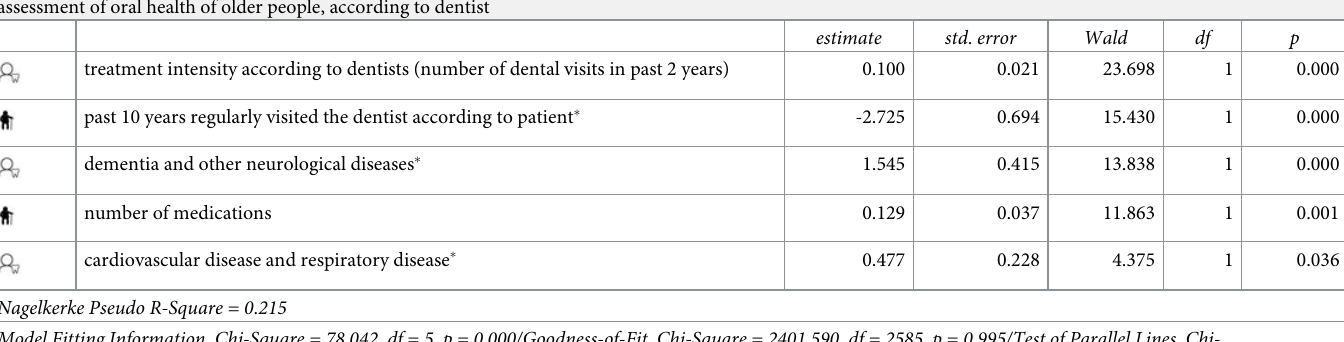
Table 6. Multivariate correlation between characteristics of older people who visit the dental practice and the assessment of their oral health, according to dentist and patient. assessment of oral health of older people, according to